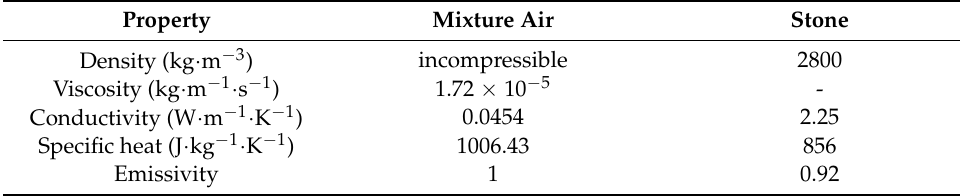
Table 4. Physical properties of the materials used.